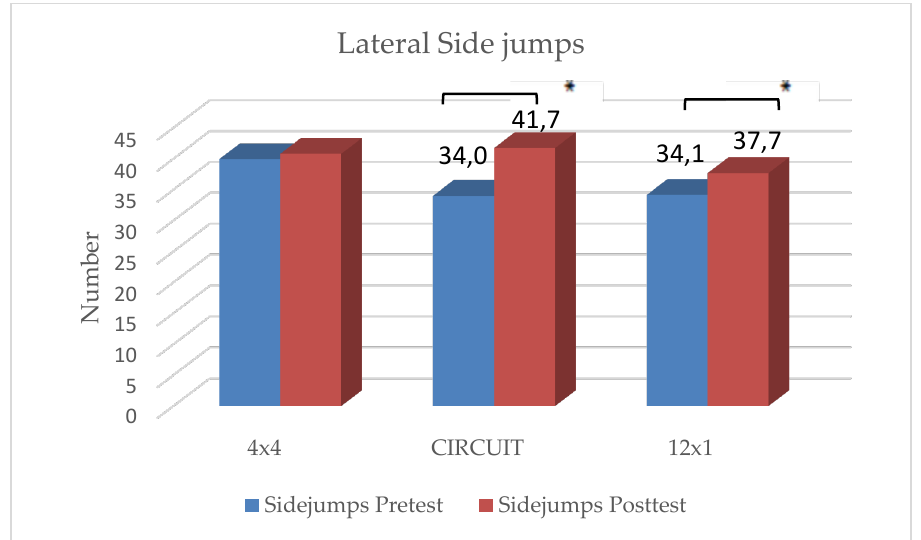
Figure 6. Changes in lateral side jumps within intervention groups. * Significant difference between pre- and posttest ( p < 0.05). Table 1. Mean values and standard deviation of performance parameters evaluated via pre- and posttests for all three intervention groups.